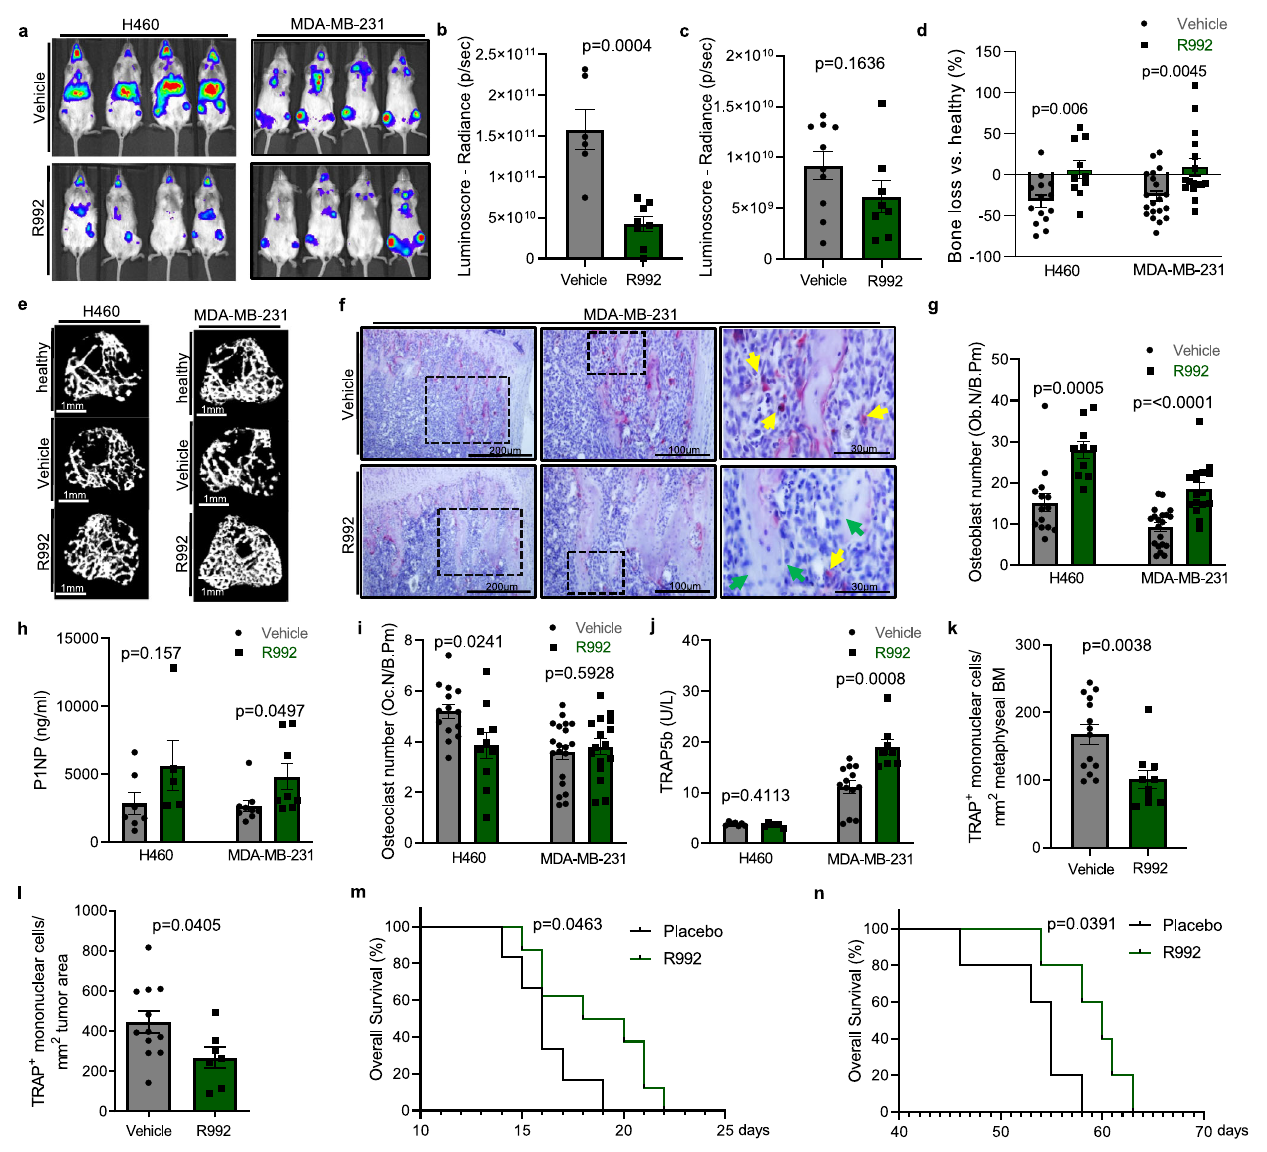
Fig. 6 | Pharmacologic MERTK blockade inhibits tumor progression and cancer-inducedbonelossinbreast-andlungcancerbonemetastasis.a – n After intracardiac injection of luciferase + H460 and MDA-MB-231 cells, NSG mice were treated with vehicle or 60mg/kg R992 BID. a Representative images from biolu- minescence imaging indicating the amount of tumor load. b , c Luminoscore (whole-bodyradianceintensity)intheH460( b )andMDA-MB-231( c )mousemodel (H460 model:Vehicle n =6 and R992 n =8;MDA-MB-231model:Vehicle n =10 and R992 n =8). d μ CT analysis of bone loss by calculating the change in bone volume (BV/TV) of tumor-bearing mice in relation to healthy age-matched control mice (H460 model: healthy controls n =5, vehicle n =14, and R992 n =10; MDA-MB-231 model:healthycontrols n =8,vehicle n =20,andR992 n =16). e 3Dreconstructions of microcomputed tomography ( μ CT) recordings of the metaphyseal proximal regionof the tibiaofhealthy andtumor-bearing micetreated withvehicleor R992. f Representative pictures of TRAP/Hematoxylin staining of bone metastasis of MDA-MB-231injectedmice.Osteoclastsarestainedinred,greenarrowspointingto osteoblasts, and yellow arrows pointing to intratumoral TRAP-positive